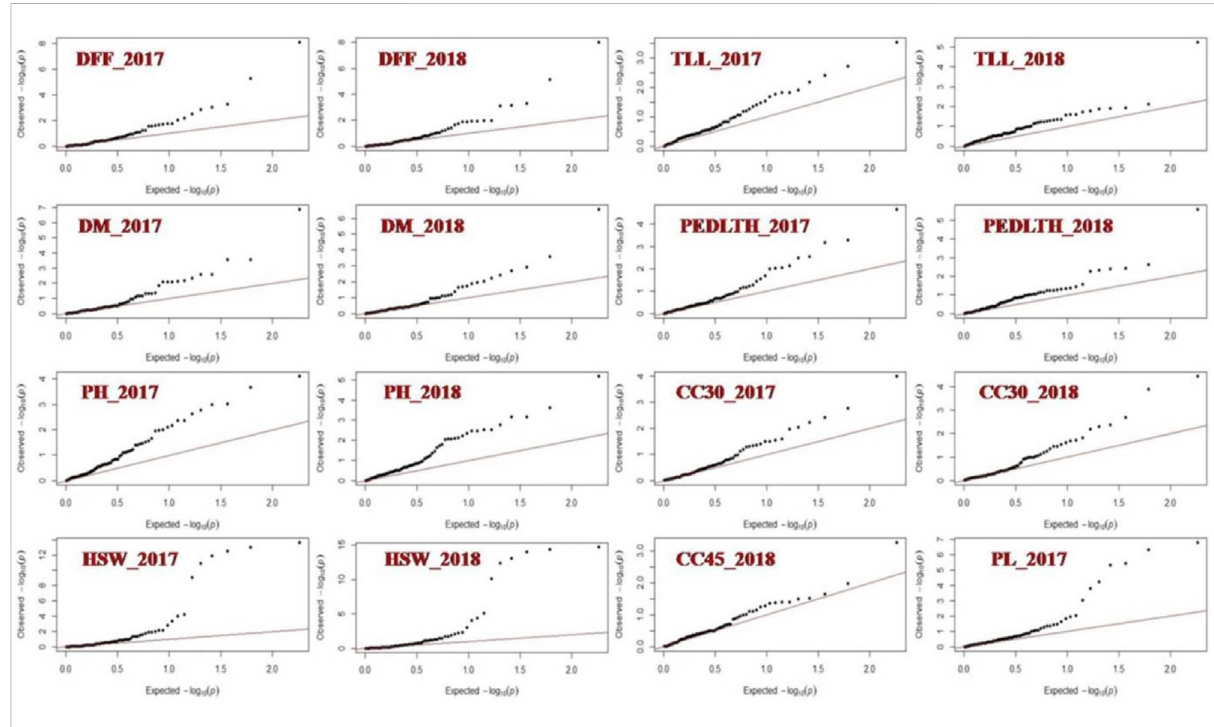
FIGURE 5 QQ bi-plot showing the association of markers with yield-related traits in Vigna